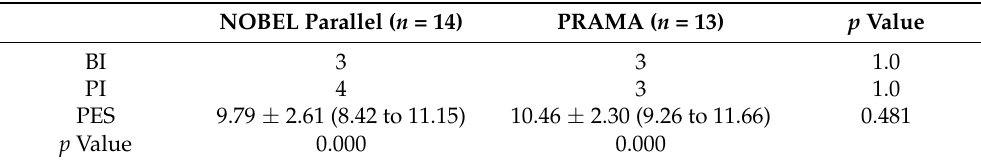
Table 6. Comparison of BI, PI and PES between